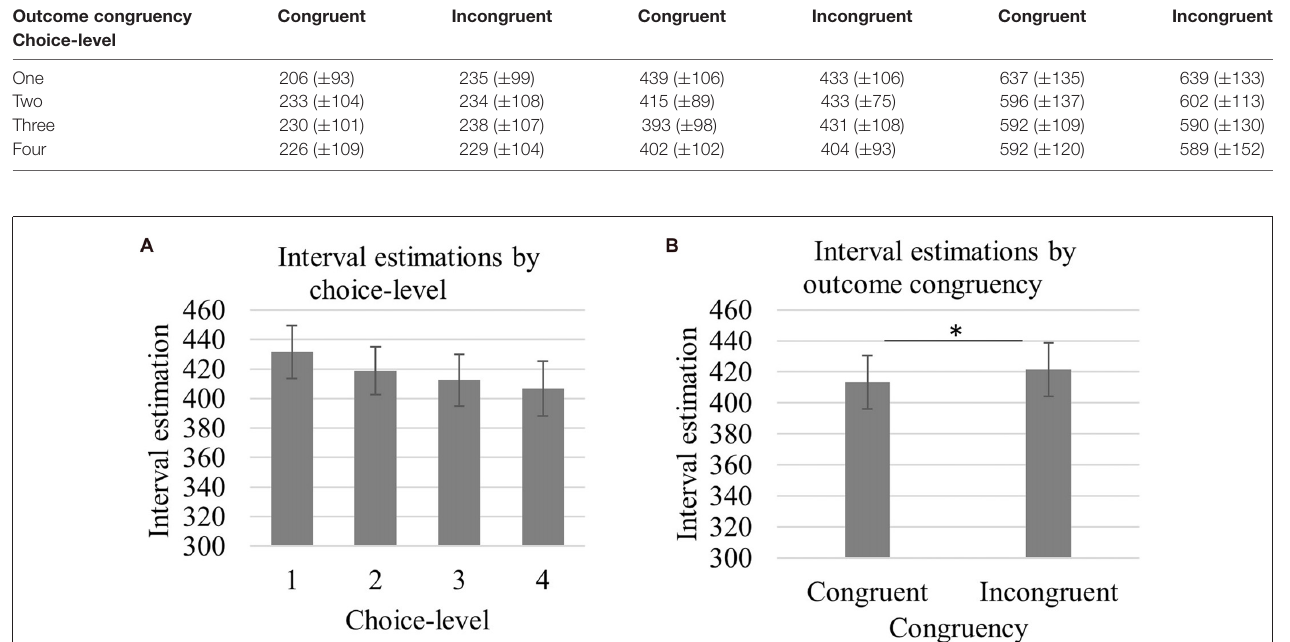
FIGURE 2 | Mean interval estimations as a function of choice-level (A) and outcome congruency (B) . Interval estimations were significantly reduced with increasing choice-level ( p < 0.001) and were greater for incongruent compared to congruent outcomes ( ∗ p = 0.047). The interval estimates were averaged across all three intervals (100 ms, 300 ms, 500 ms). Error bars represent standard error of the mean.